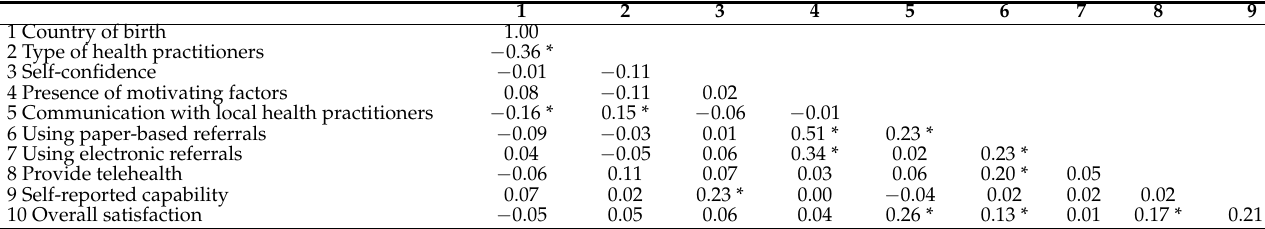
Table 2. Correlation coefficients between selected